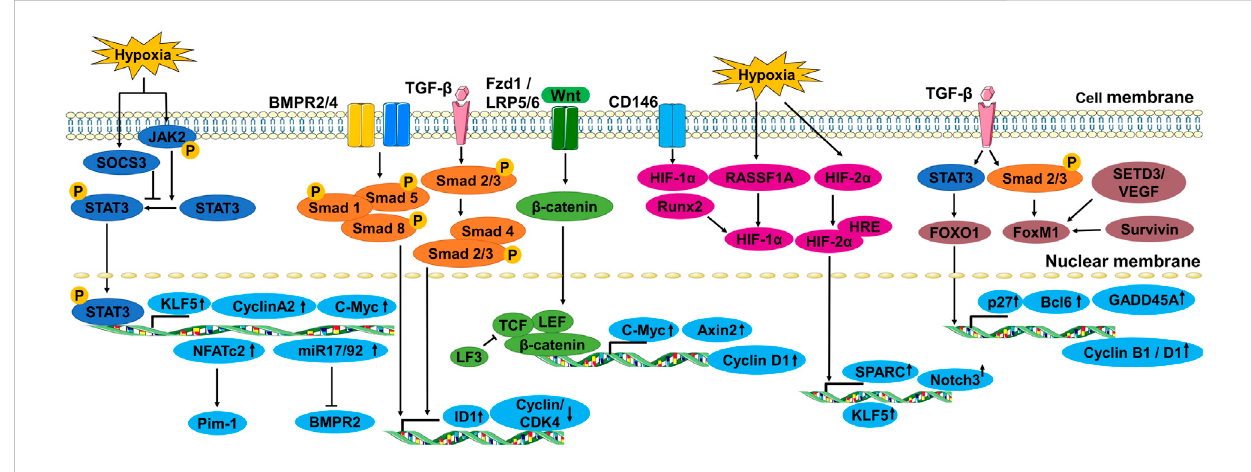
FIGURE 1 The transcription factors and signal pathways associated with PASMC proliferation in